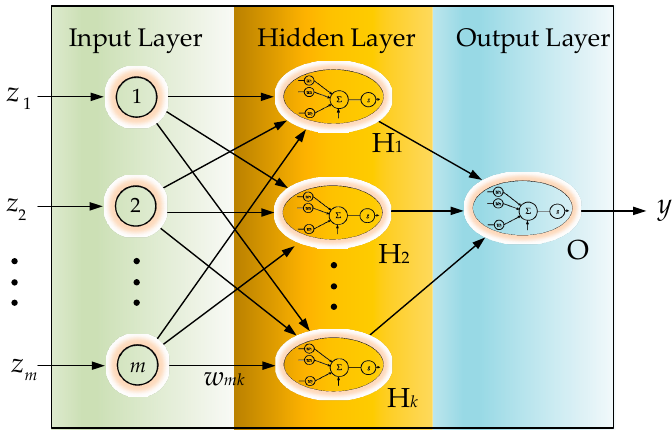
Figure 7. Neural network architecture.